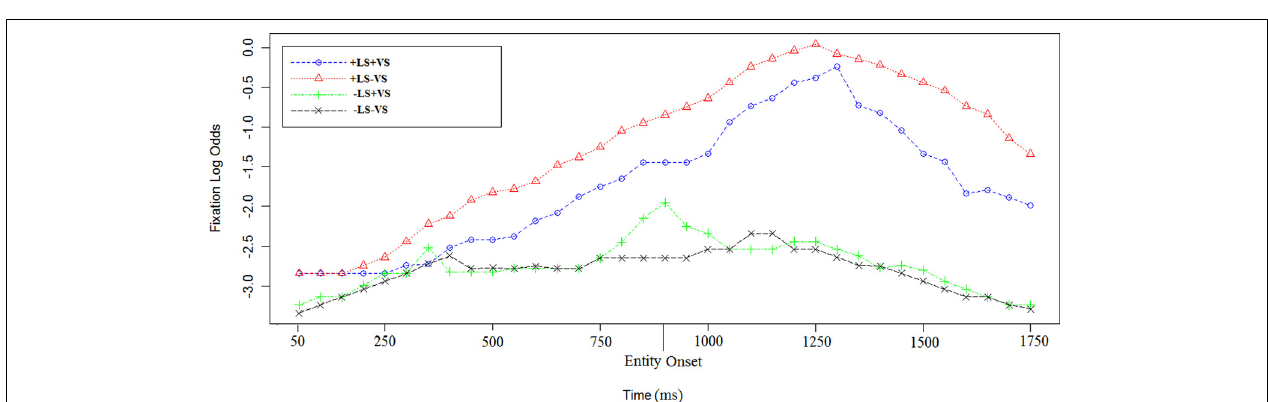
The entity onset in + LS condition (e.g., “Depero”) is reported on the graph as well. Each data point corresponds to 50ms in the time course.